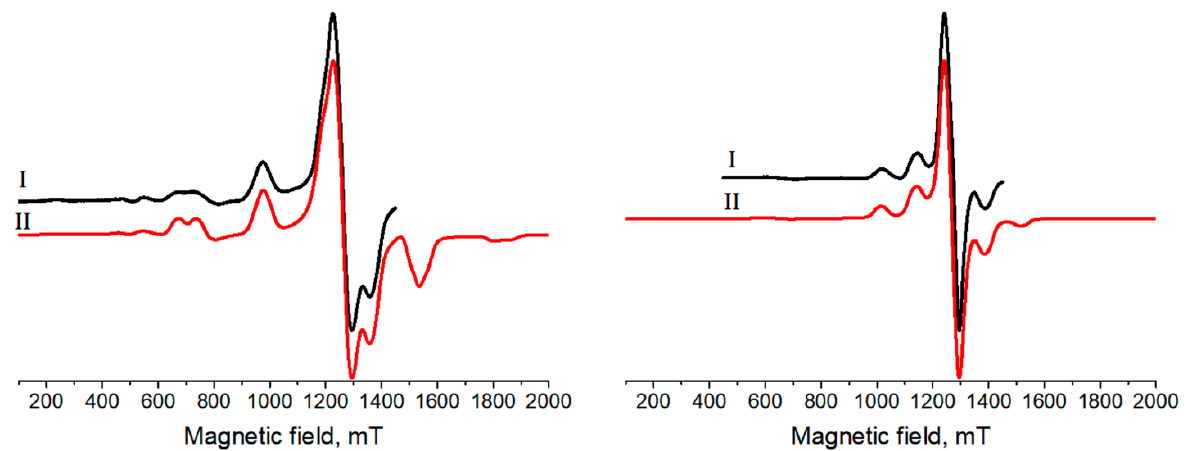
Figure 5. Q-band EPR spectra of solid 1 ( left ) and 2 ( right ) at 300 K. (I—experimental, II—the best fit of the experimental data). Table 3. Experimental and calculated EPR parameters for polycrystalline complexes 1 and 2 .